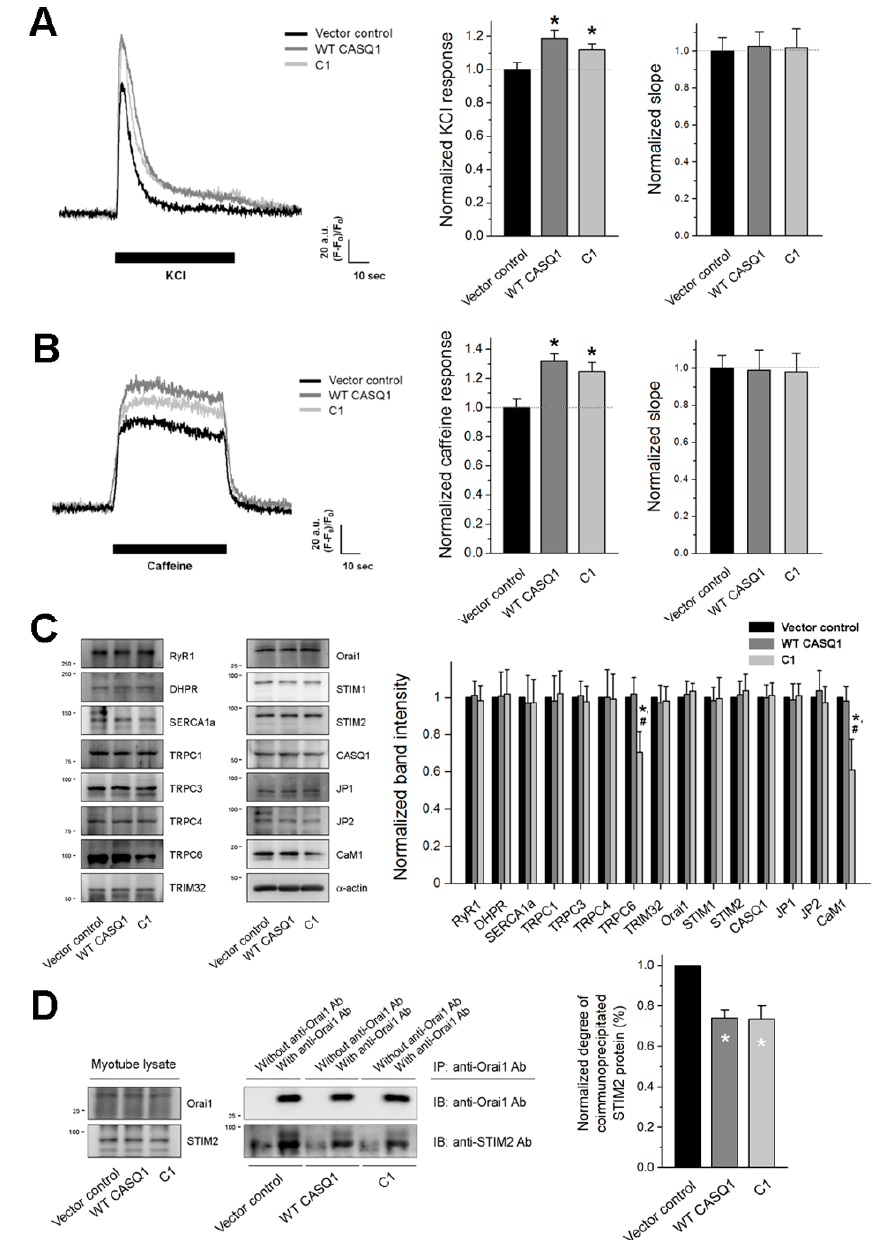
Figure 3. Intracellular Ca 2+ release for skeletal muscle contraction, expression levels of various proteins, and coimmunoprecipitation of Orai1 with STIM2: KCl ( A ) or caffeine ( B ) was applied to the myotubes, and intracellular Ca 2+ release from the SR to the cytosol through RyR1 was measured. A representative trace for each group is shown. Histograms show the normalized peak amplitude (left-hand side) or the slope in the rising phase of the peak to the mean value of the vector